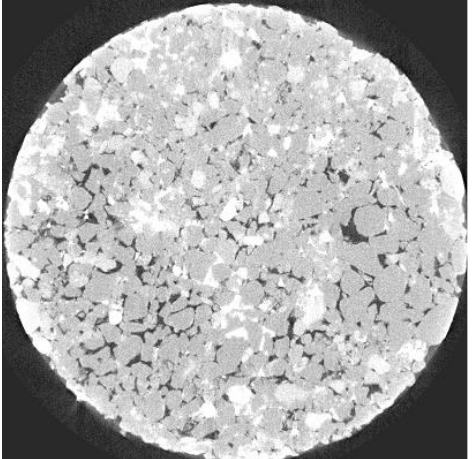
Figure 2. Example of gray-scale micro-CT scan of sandstone rock sample in this study.